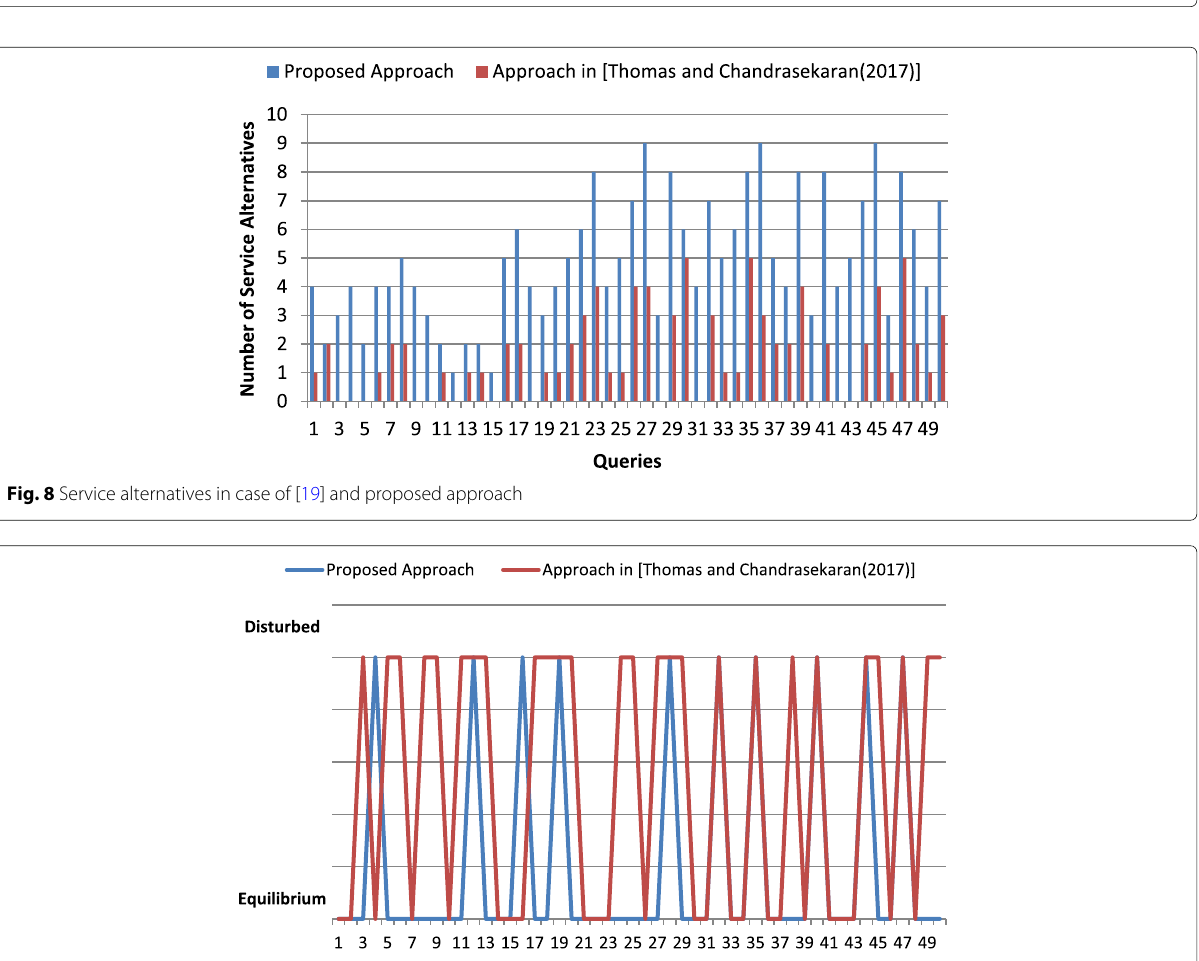
Fig. 9 State of equilibrium in case of [19] and proposed